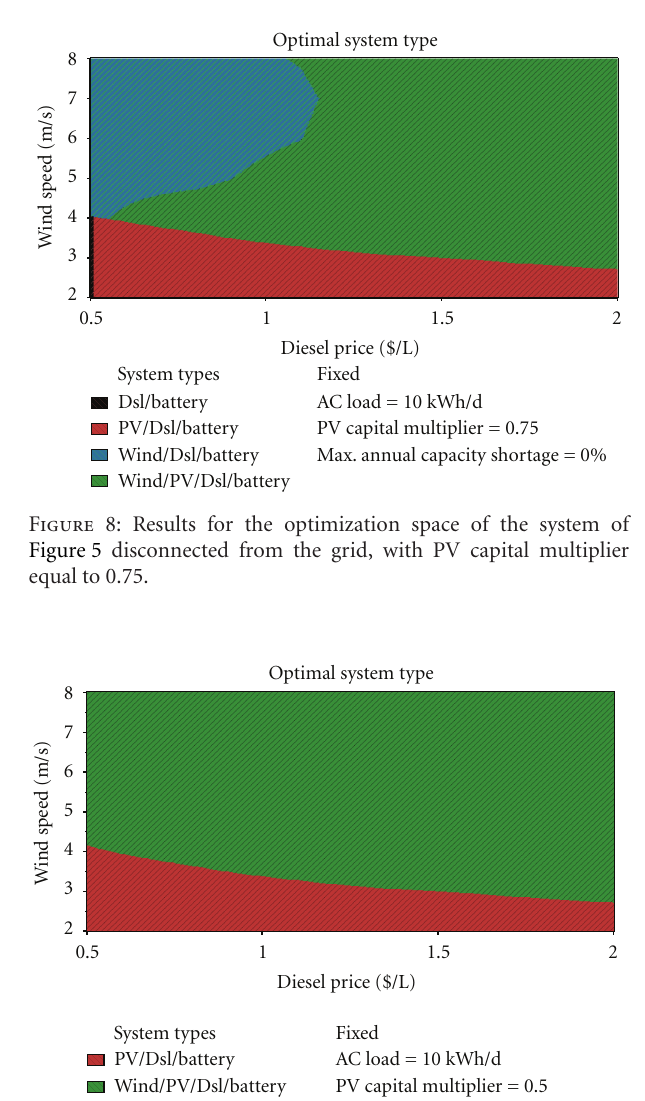
Figure 7: Results for the optimization space of the system of Figure 5 disconnected from the grid, with 16kWh/d AC load.